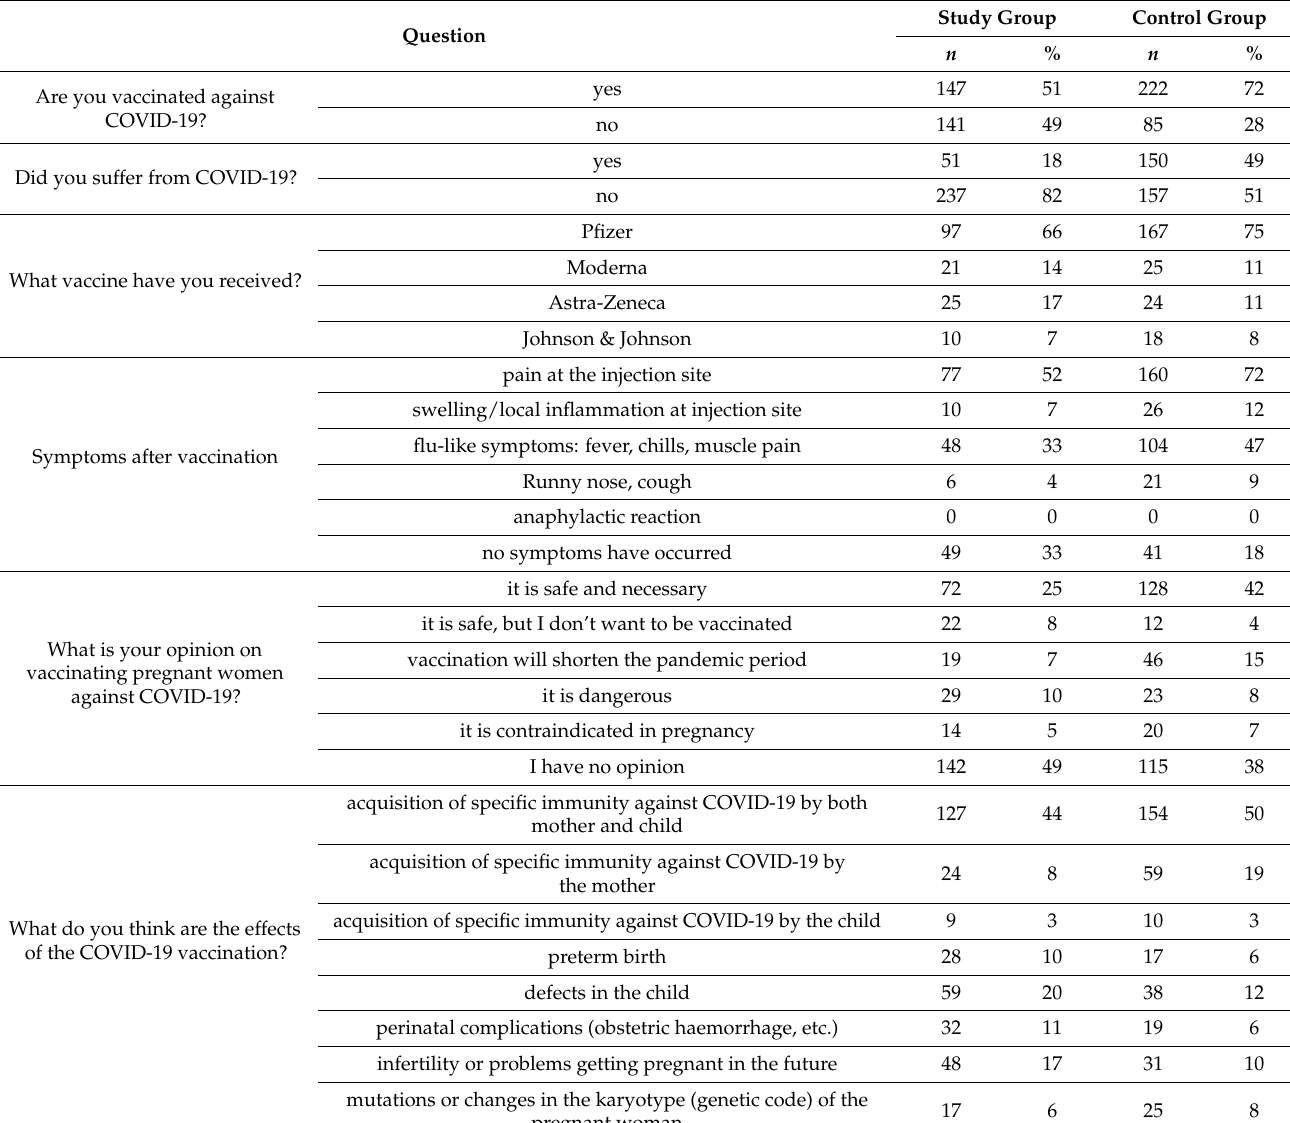
Table 2. Analysis of the author’s original